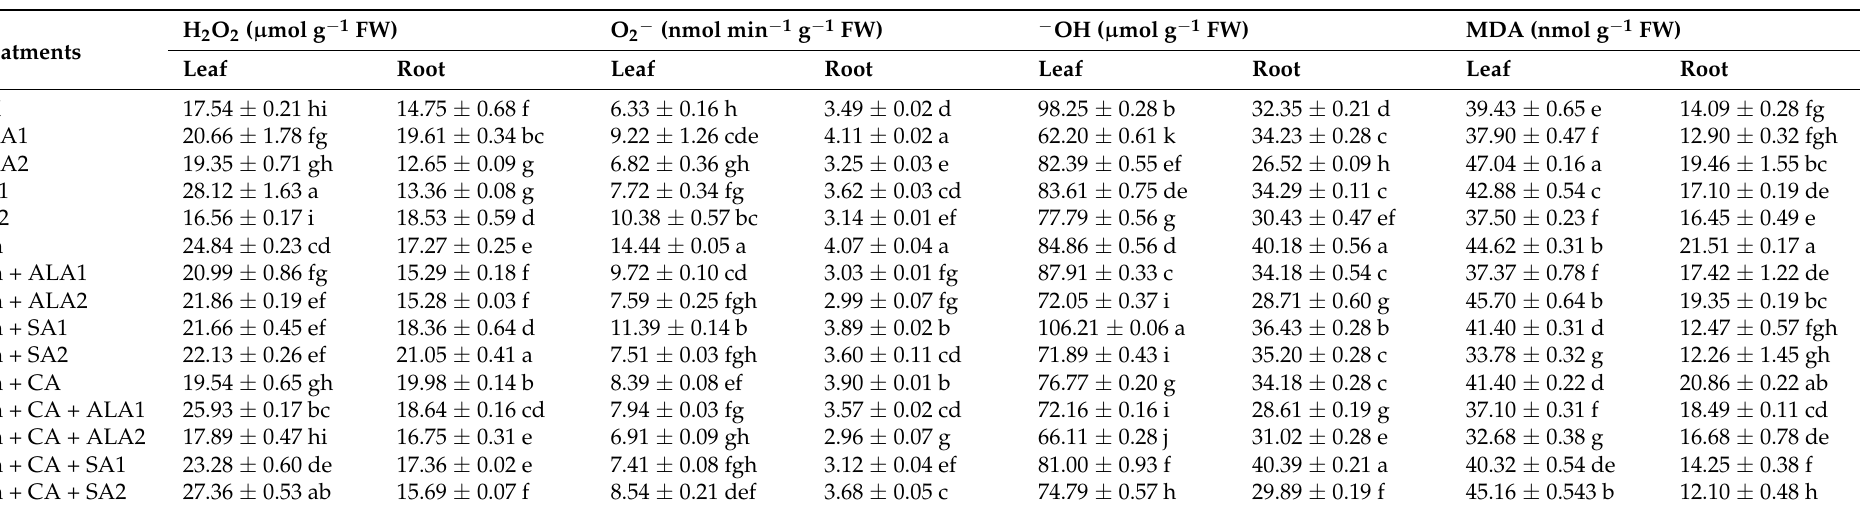
Table 2. Effects of 5-aminolevulinic acid or salicylic acid (ALA/SA) combined with citric acid on hydrogen peroxide (H 2 O 2 ), superoxide radical (O 2 − ), hydroxyl ion ( − OH) and malondialdehyde (MDA) contents in sunflower leaves and roots under manganese (Mn)